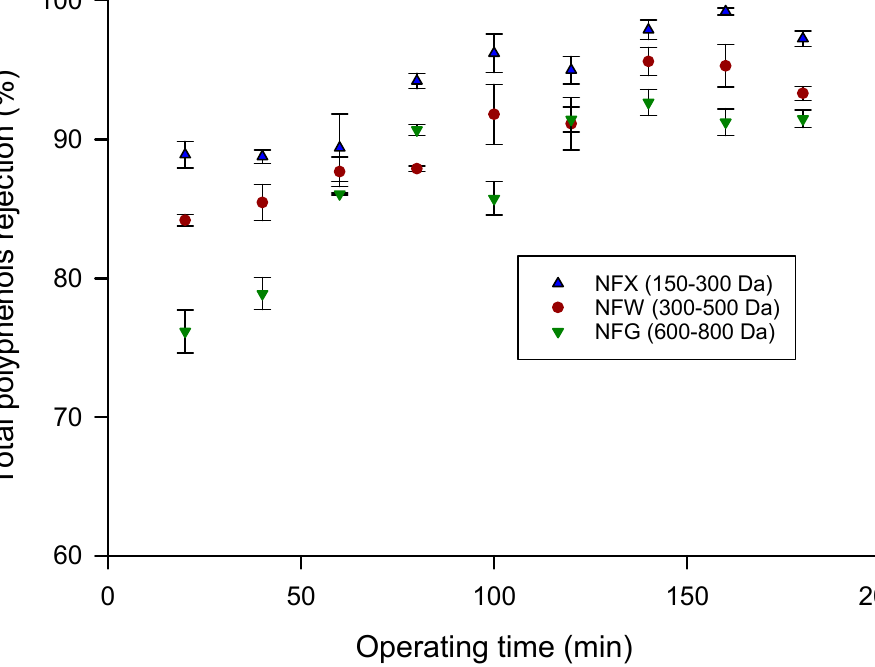
Figure 2. Time course of polyphenols rejection for selected membranes.